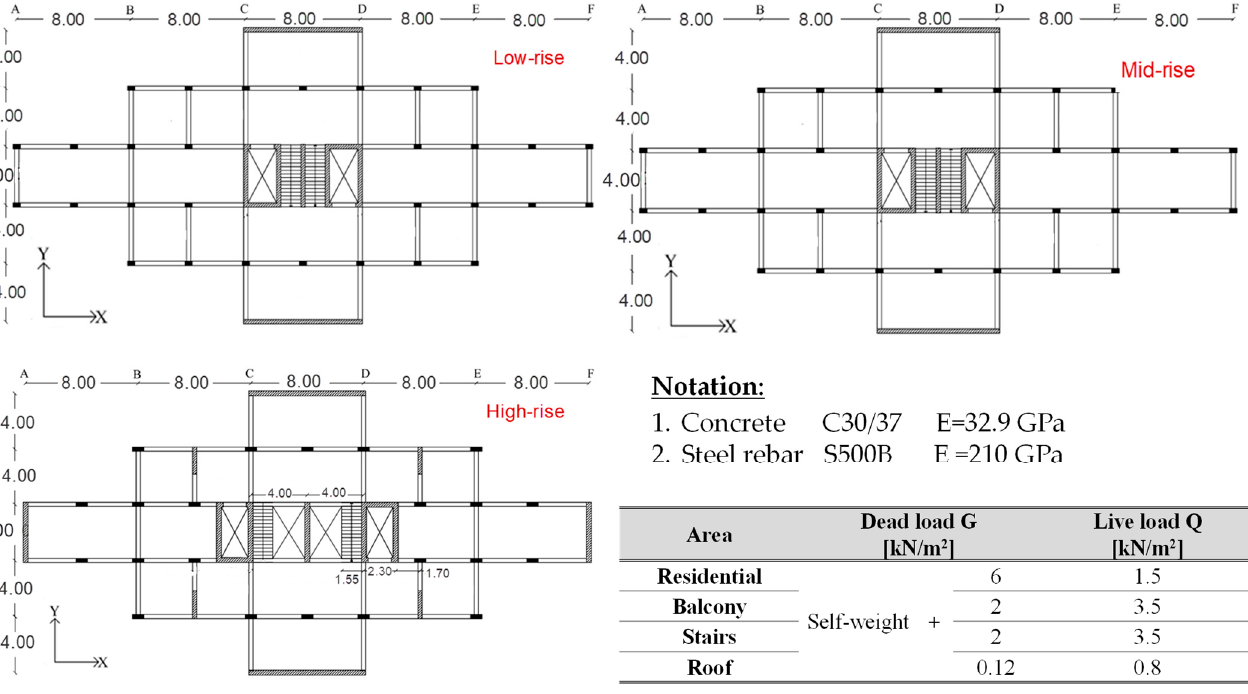
Table 1. Description of the investigated buildings.